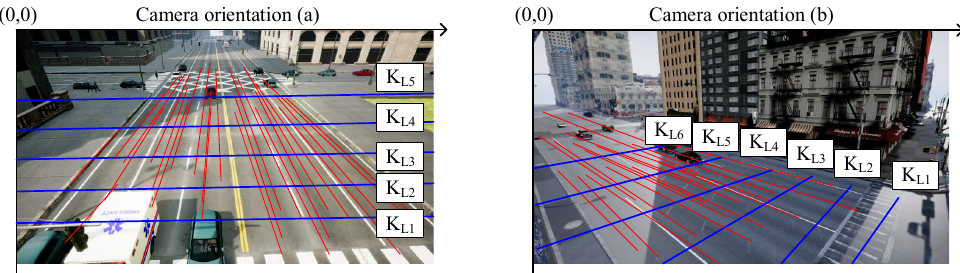
Figure 3. Feature lines in different camera orientations: ( a ) the directions of feature lines are similar to each other; and ( b ) the directions of feature lines are much more